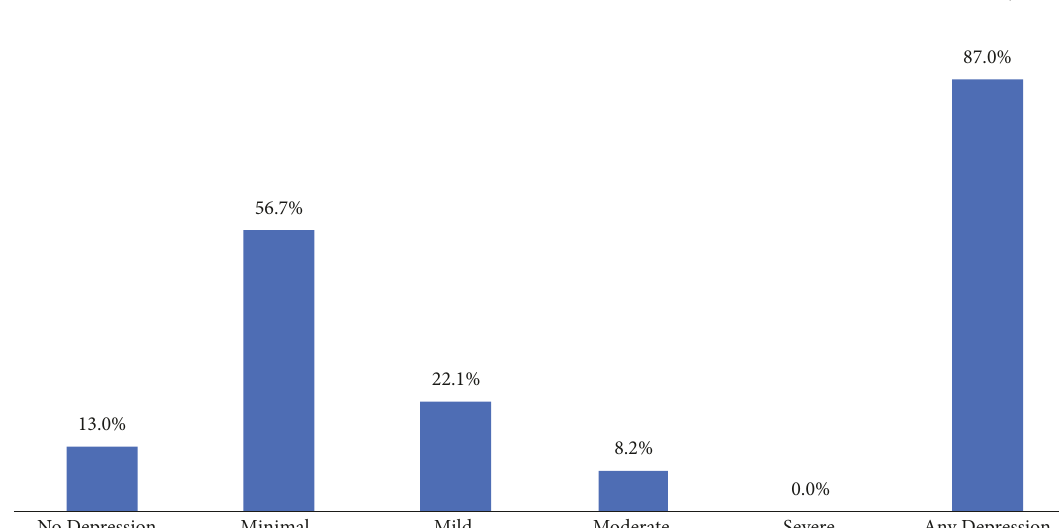
Figure 1: Prevalence of depression among diabetes